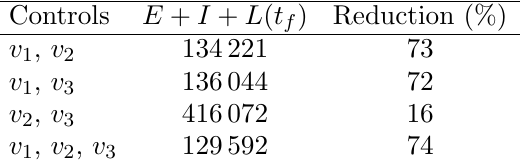
Table 2. Total infected E + I + L at the end of the period when different interventions are combined